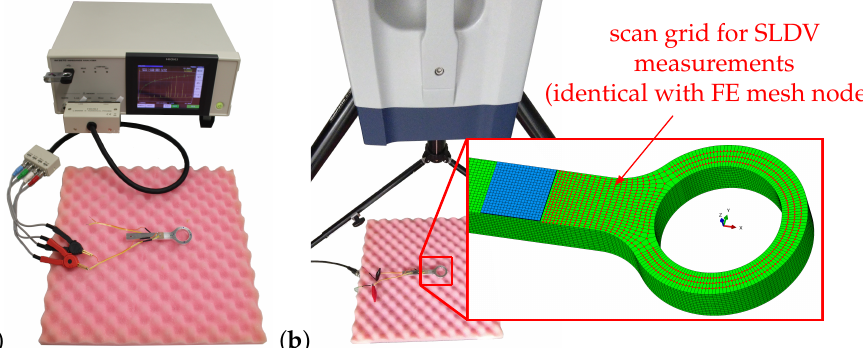
Figure 3. Test setups for measurements of a simplified lug (exitation at PWAS1) with ( a ) IMA (Hioki IM 3570), ( b ) SLDV (Polytec